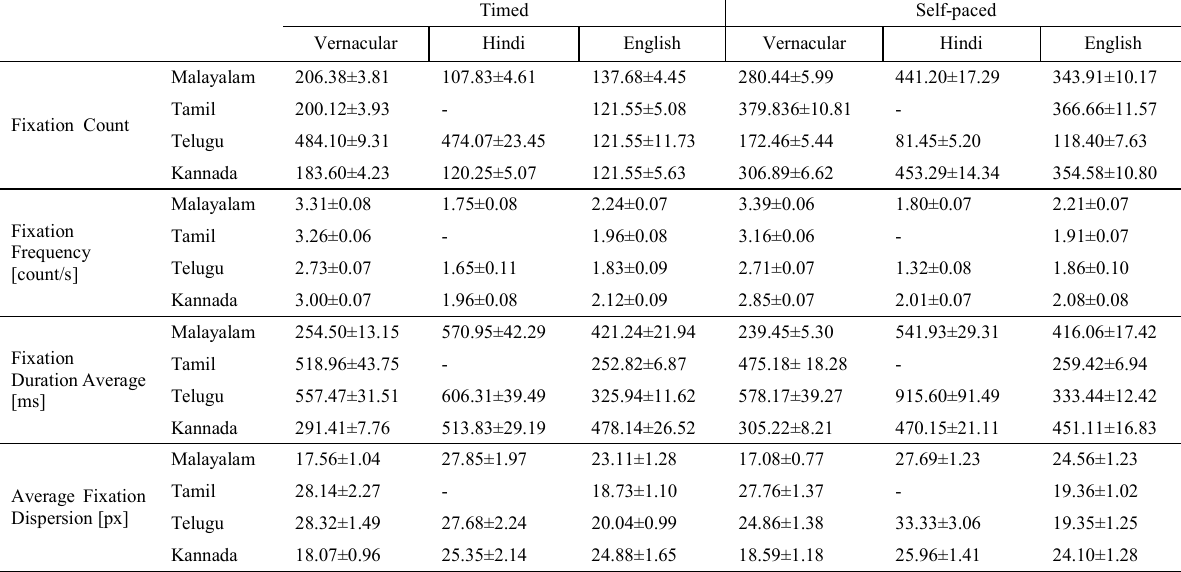
Table 3: Fixation variables for different Dravidian language groups (n = 44) while reading vernacular and non-vernacular in time bound and self-paced manner. Data presented as mean± SEM. SEM= Standard error of mean. Timed